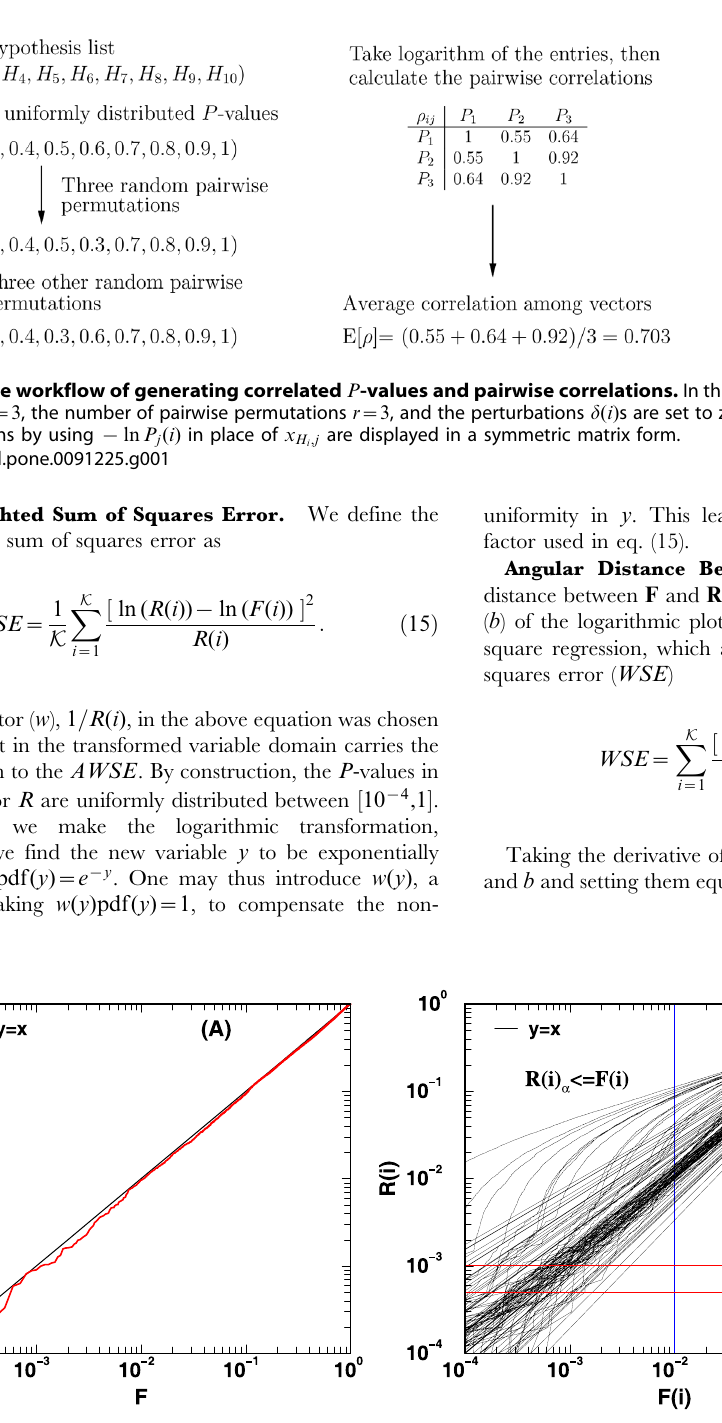
Figure 2. Log-log plot of the unified P -value vector F versus the rank vector R . The curves in panels (A) and (B) were obtained from combining the P -values of four P -value vectors, each of size 10,000, using Stouffer’s method. In panel (A), the red circles show the scatter plot of normalized rank versus computed P -value from a randomly picked iteration (realization) of very weak average correlation. It is through curves like the one displayed in panel (A) that enables one to calculate the average sum of squares error using eq. (15) and the distance measure using eq. (16). Panel (B) shows 1000 curves, each of which is obtained from performing the same task as that leads to the curve in (A) but with different average correlation strengths. The lines that go significantly above y ~ x line are from cases with stronger average correlations. They yield unified P -values that are much exaggerated perhaps due to the fact that the Stouffer’s method does not account for correlations. By averaging the normalized rank R along the blue line ( F ~ F c ) yields the value E ½ R ( F c ) (see eq. (17)). By shifting the blue line to different F c values renders the entire E ½ R ( F c ) (cid:2) versus F c curve. The red horizontal line illustrates the case when i ~ 10 (or normalized rank R (10) ~ 10 { 3 ). By averaging the { ln F values along this line, the R ( i ) E ½ ln( )) (cid:2) value is obtained for i ~ 10 by simply adding ln(10 { 3 ) to the averaged value (see eq. F ( i